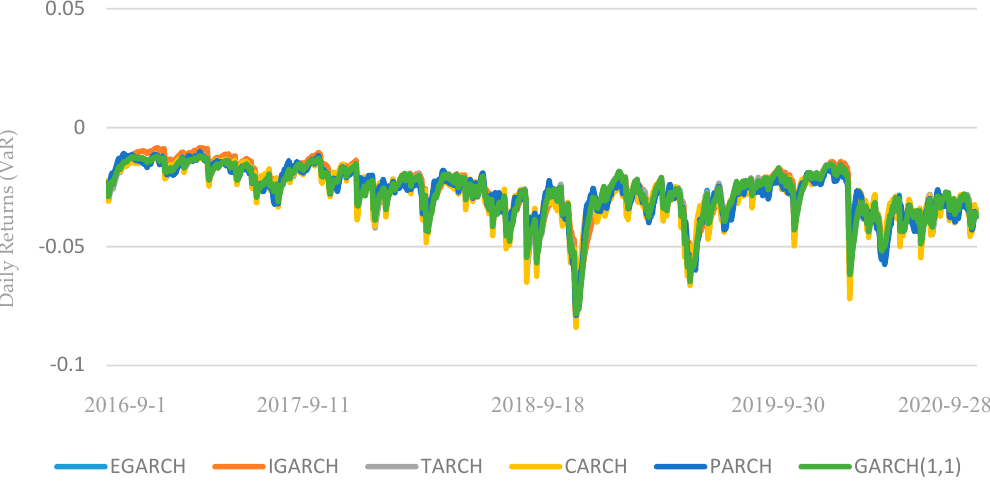
Figure 3. VaR Values of several alternative specifications of GARCH models. (31 August 2016–1